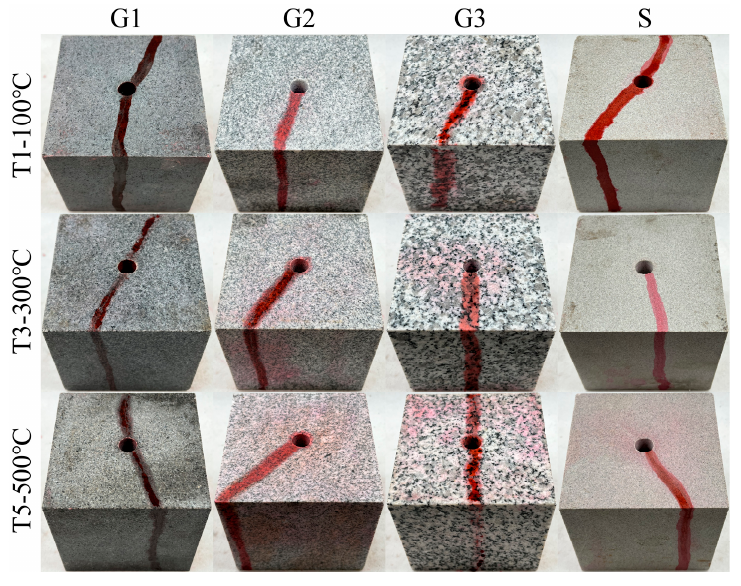
Figure 9. Photograph of HFS specimens of G1, G2, G3, and S lithologies after fracturing.